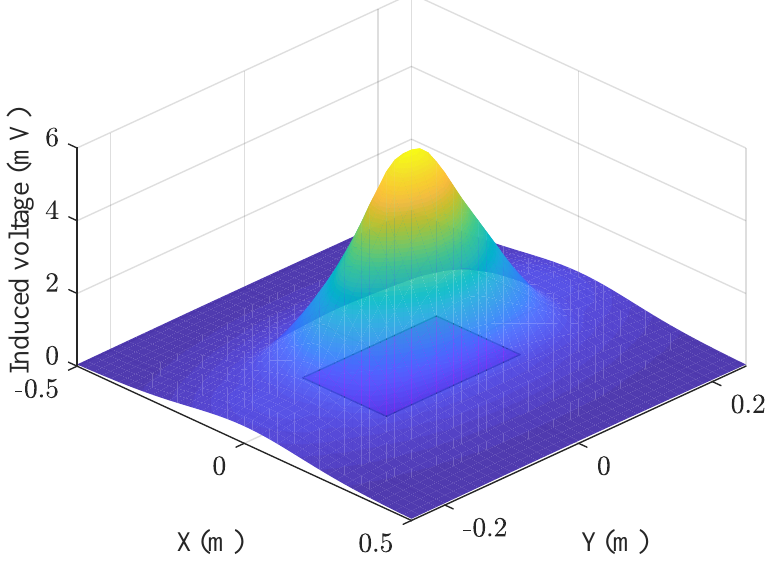
Figure 3. Induced voltage at a height of 0.2